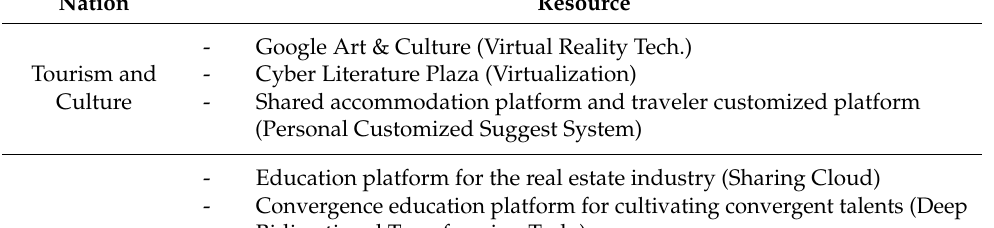
Table 2. Online and mobile platforms by industry